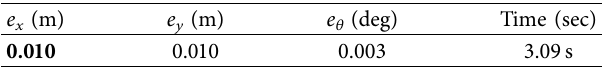
Table 15: The mean of the PF (two landmarks with non-Gaussian